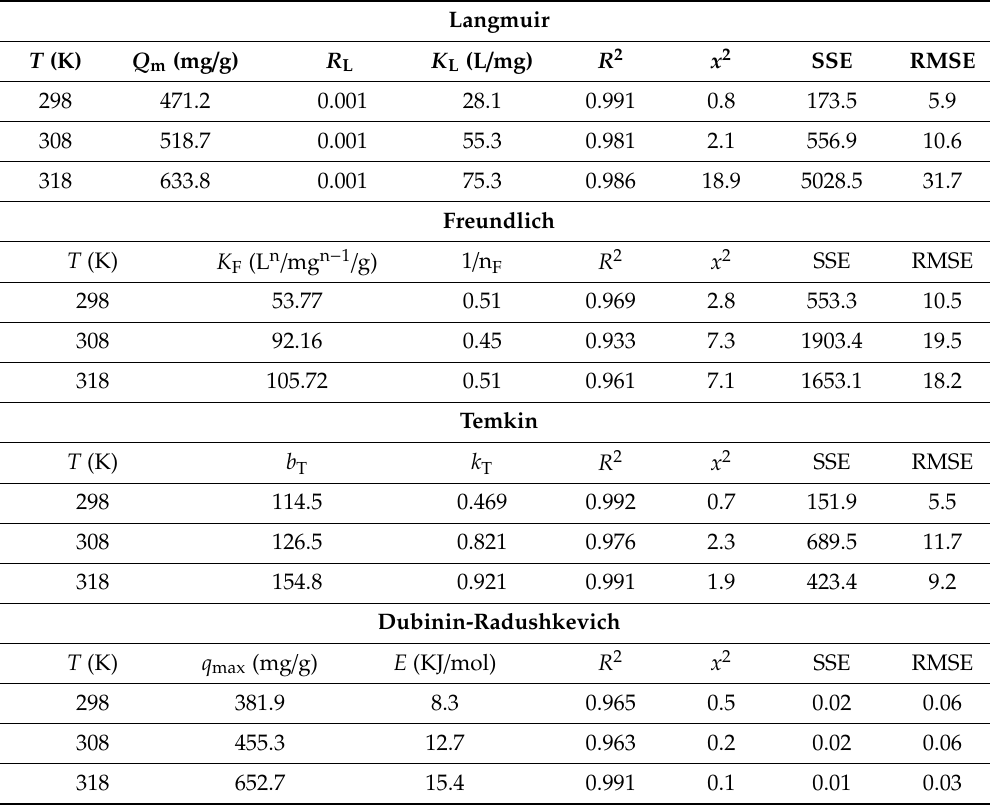
Table 3. Adsorption isotherm parameters of PPy-Fe 3 O 4 / Kaolin.